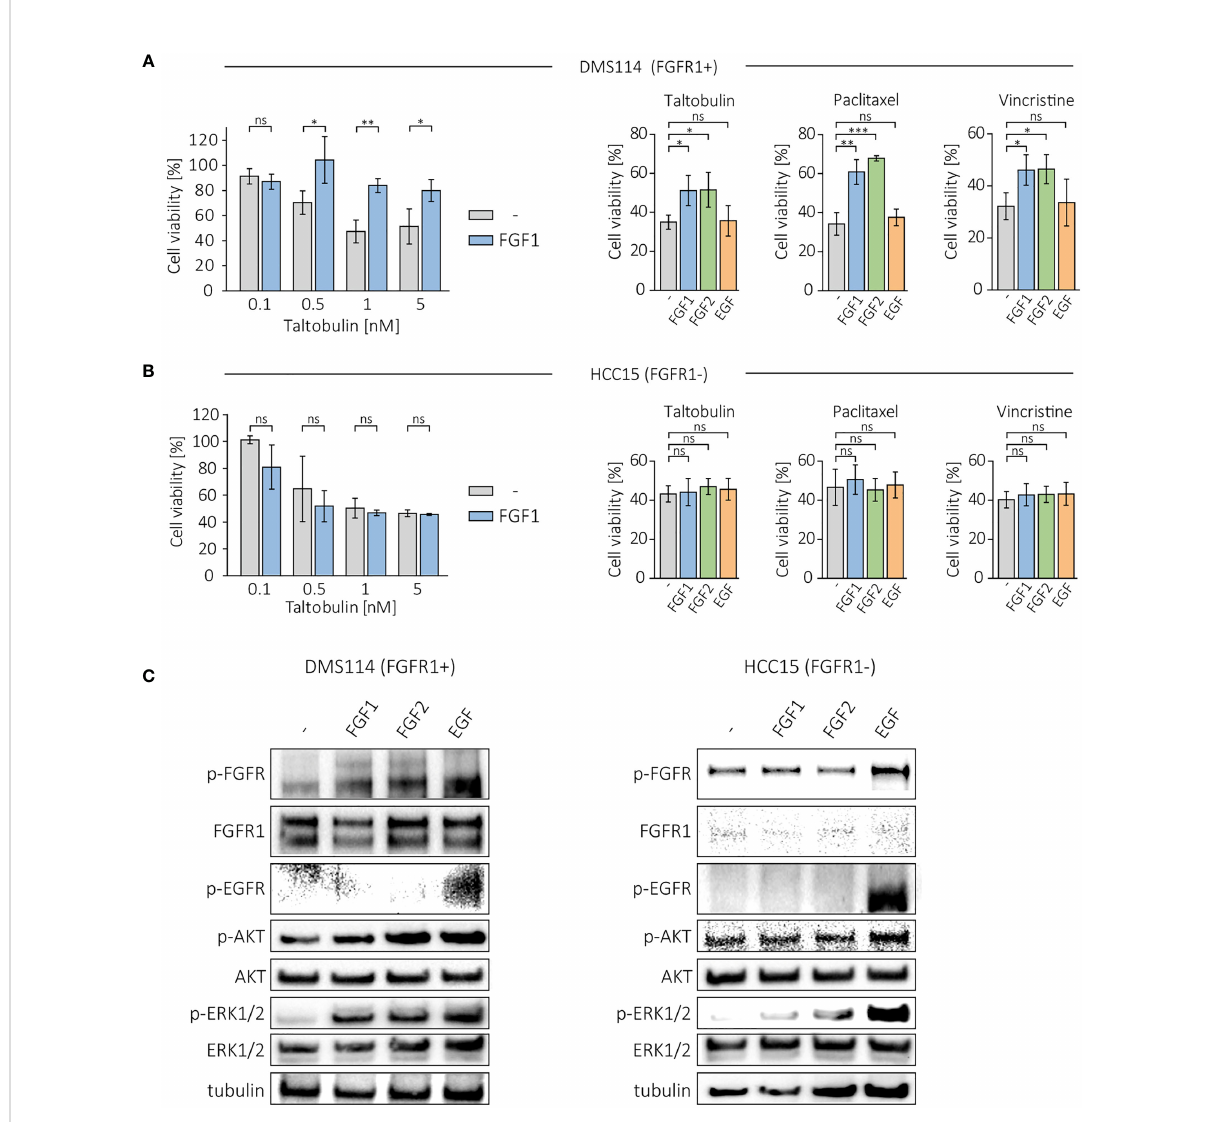
FIGURE 2 Effect of FGF1, FGF2 and EGF in DMS114 and HCC15 cells treated with the indicated drugs. Viability of (A) DMS114 and (B) HCC15 cells treated with different concentrations of TLT in the presence of 10 ng/mL FGF1 for 48 h (left panels) and comparison of the effect of FGF1, FGF2 and EGF (10 ng/mL) in cells treated for 48 h with 5 nM TLT, 20 nM PTX and 10 nM VCR (right panels). Cell viability was monitored using the alamarBlue assay. Results represent the mean ± SD of at least three independent experiments and are normalized to untreated cells; statistical signi fi cance: *p<0.05, **p<0.01, ***p<0.001, no signi fi cant differences are marked as ‘ ns ’ . (C) Western blotting analysis of FGF1, FGF2 and EGF (10 ng/mL) activity in DMS114 and HCC15 cells using anti-phospho-FGFR, anti-FGFR1, anti-phospho-EGFR, anti-phospho-AKT, anti-AKT, anti- phospho-ERK1/2 and anti-ERK1/2 antibodies. Anti-tubulin antibody served as an equal loading